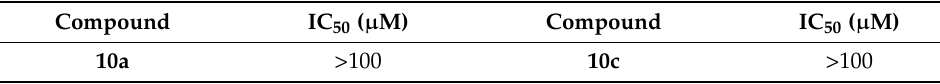
(Table 5.) suggested the carbohydrate-based coumarins 10a and 10c had no apparent cytotoxicity toward MCF-10A cell line (IC 50 >100 µ M). Table 5. Inhibitory activity against normal cell line MCF-10A.